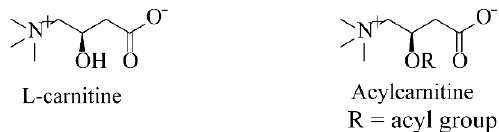
Figure 1. The structure of L -carnitine and acylcarnitines.